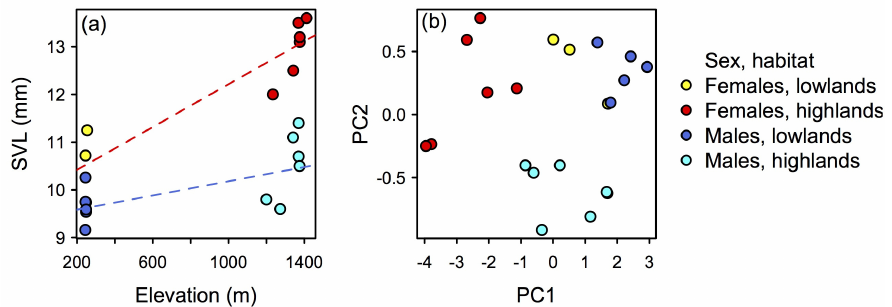
Figure 11. Multi-panel plot displaying variation of body size and body shape in Noblella losamigos sp. n. across elevations. ( a ) Body size in females and males tends to increase with increasing elevation. ( b ) Projection of Principal Component Analysis based on body-size-corrected data; body shape differs between females and males and varies with respect to elevation.